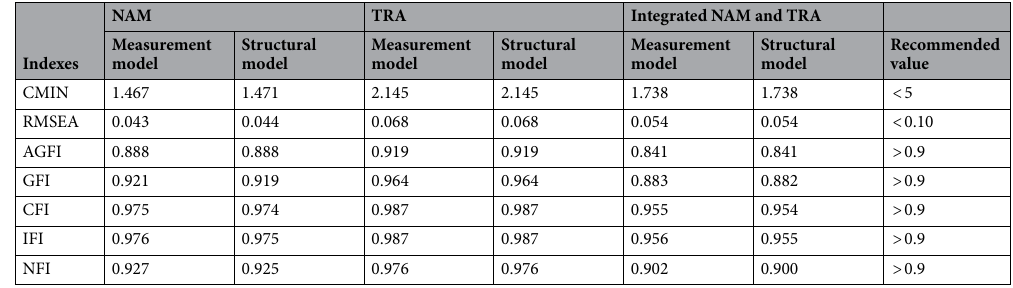
Table 3. Fit index.